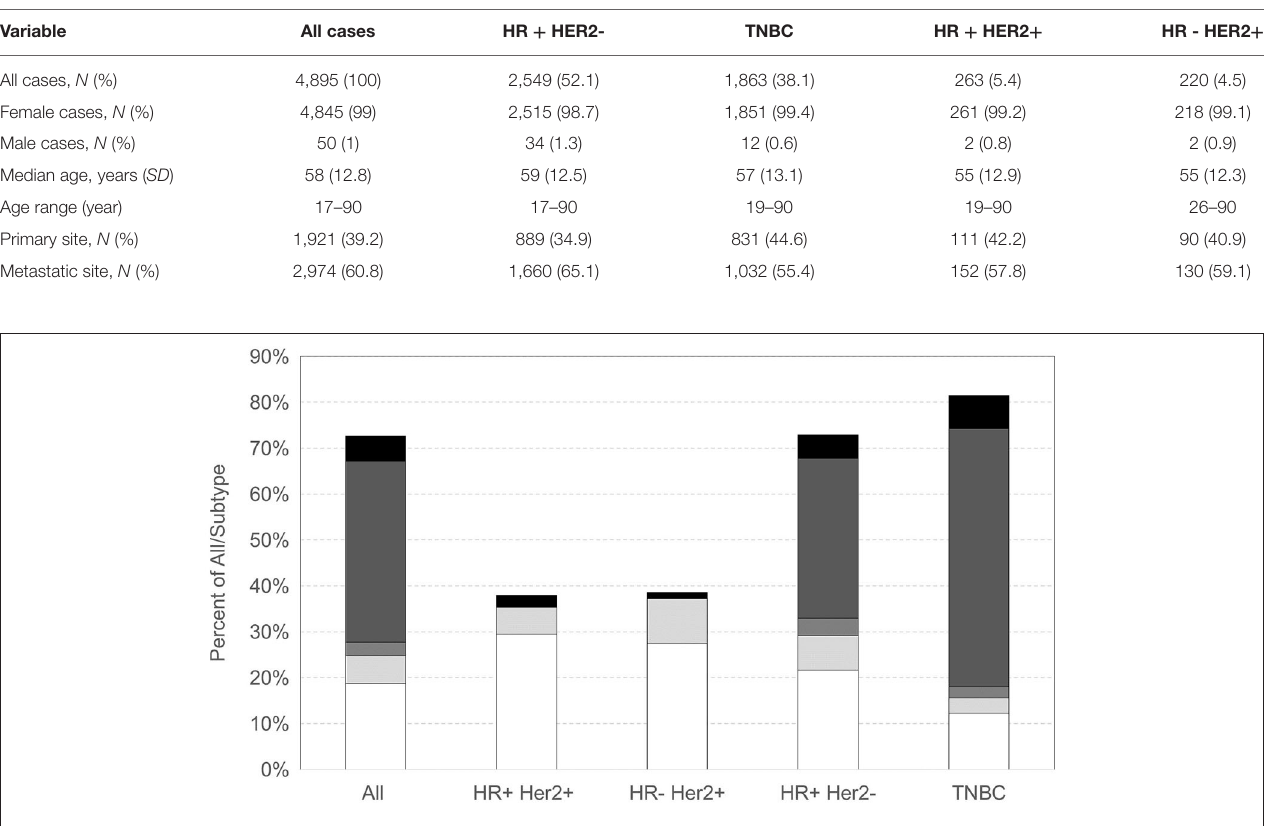
AKT1 mutations. Table S2 describes the most common PIK3CA- AKT1-PTEN pathway-associated genes and their frequencies in our